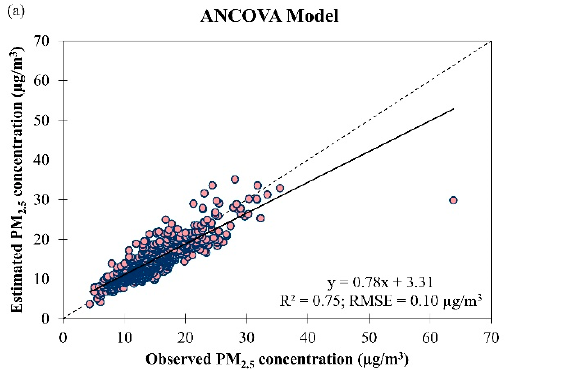
Figure 6. Scatter plots of estimated daily PM 2.5 concentration against observed daily PM 2.5 concen- tration by ( a ) ANCOVA and ( b ) RFR models for overall air quality in Singapore from March 2016 to February 2018.